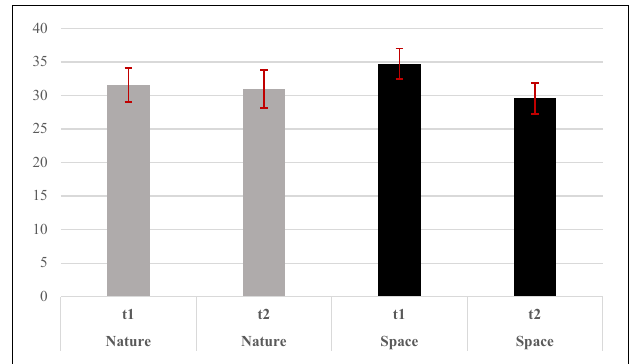
FIGURE 1 | Bar chart of means and standard errors of weight estimations given by subjects in the two conditions at t1 and t2.